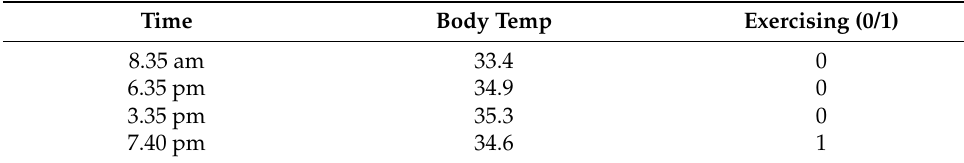
Table 5. Average body temperature of a day (I.R. sensor).